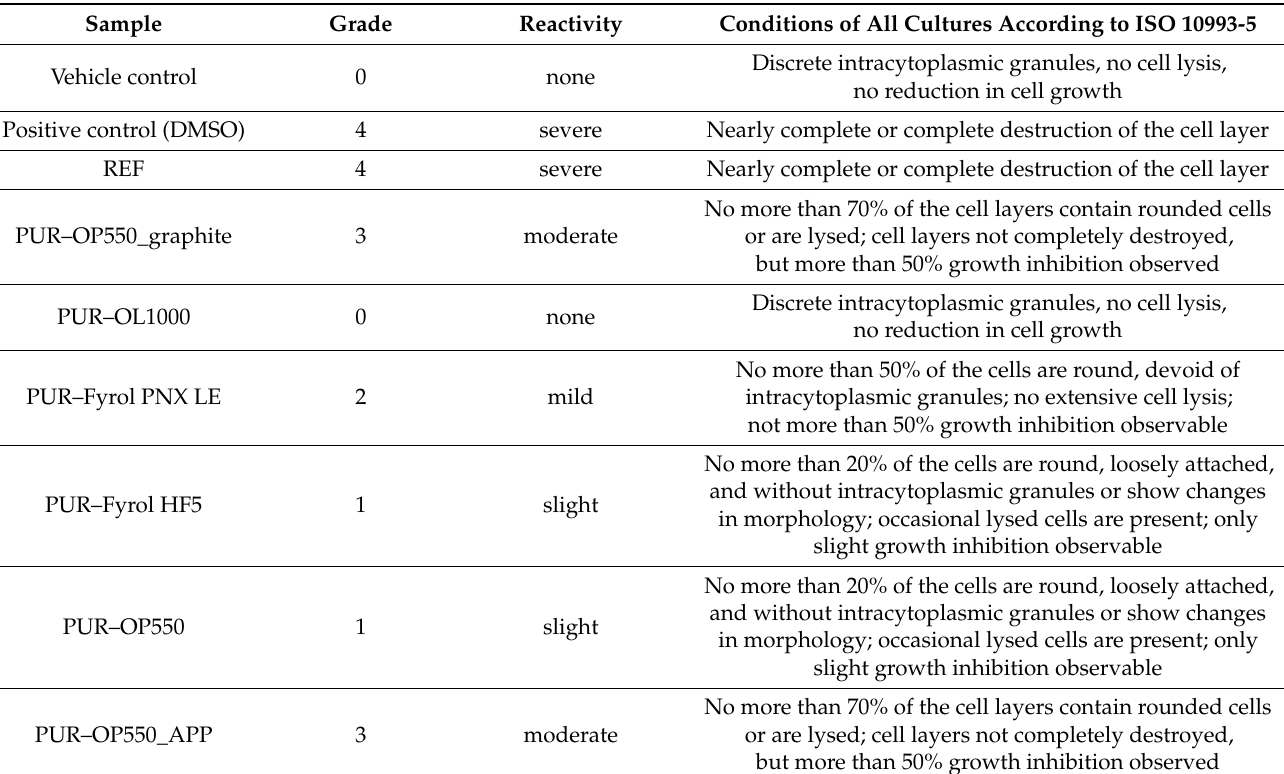
Table 11. Qualitative morphological grading of cytotoxicity of PUR foam extracts (25% concentrations) according to ISO 10993-5 observed in an inverted microscope before adding neutral